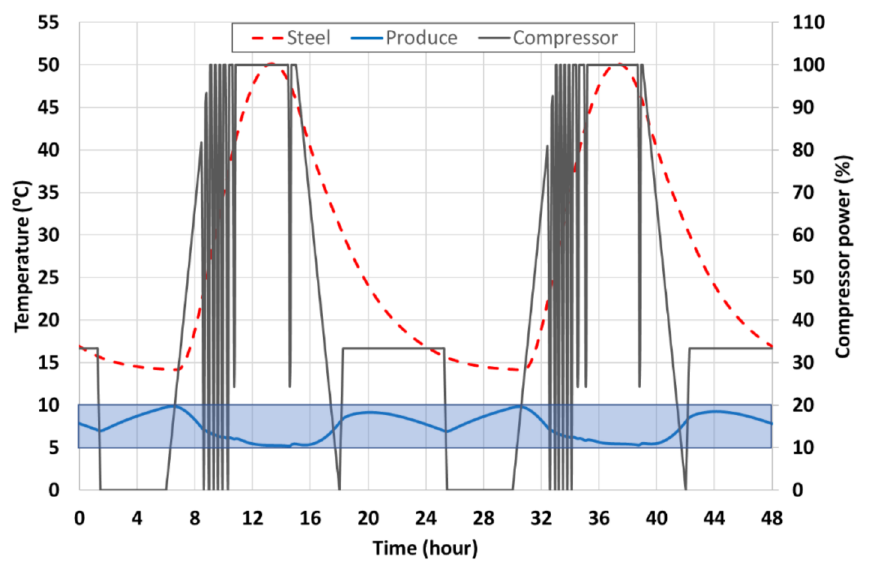
Figure 22. Produce temperature when running the compressor for an additional 7 h at night at a 33% power